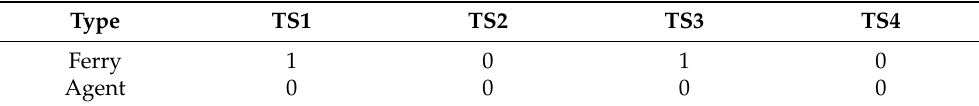
Table 5. Crossing patterns comparison.